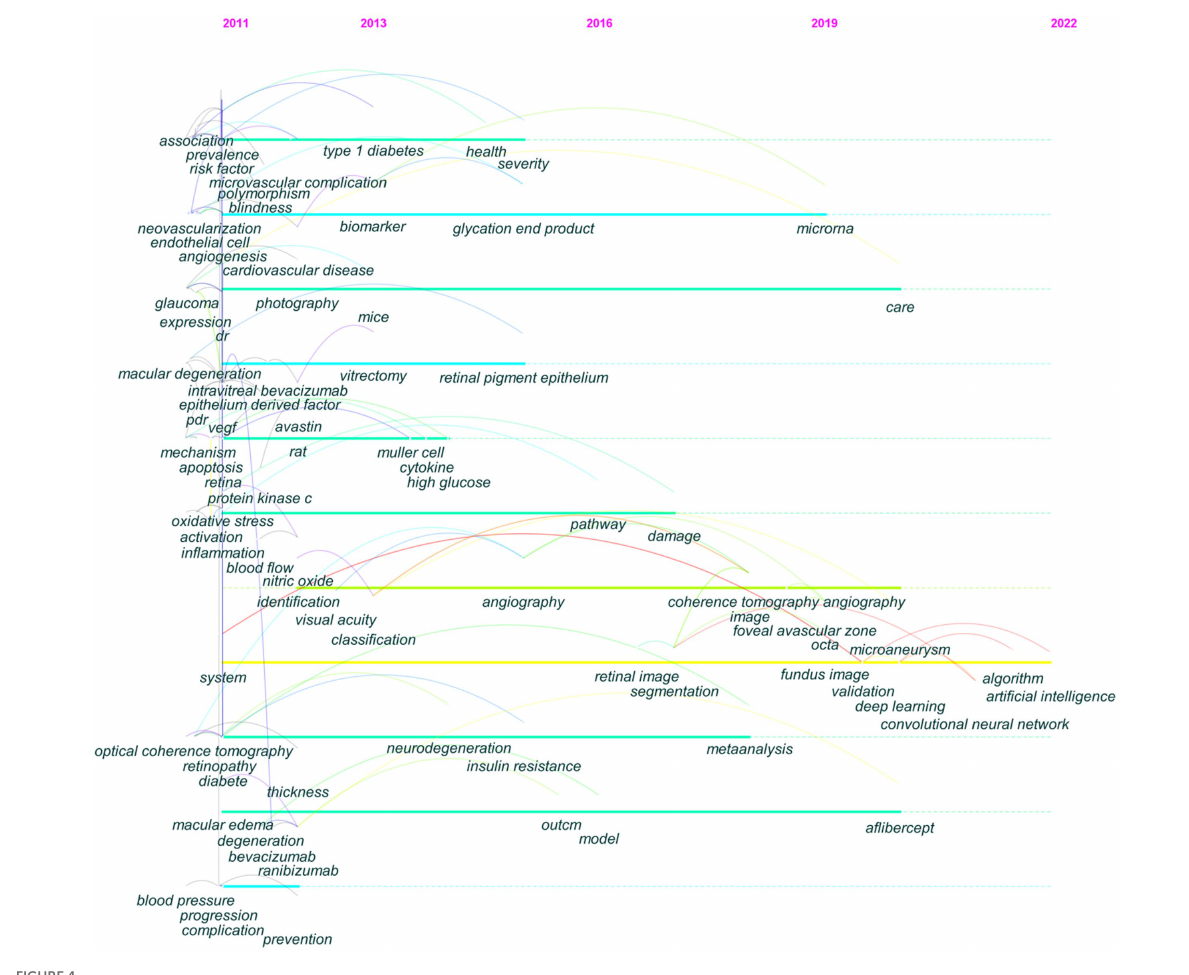
FIGURE 4 The evolutionary path of keywords detected by CiteSpace. The corresponding year of each node keyword was the year of high-frequency occurrence of the keyword.